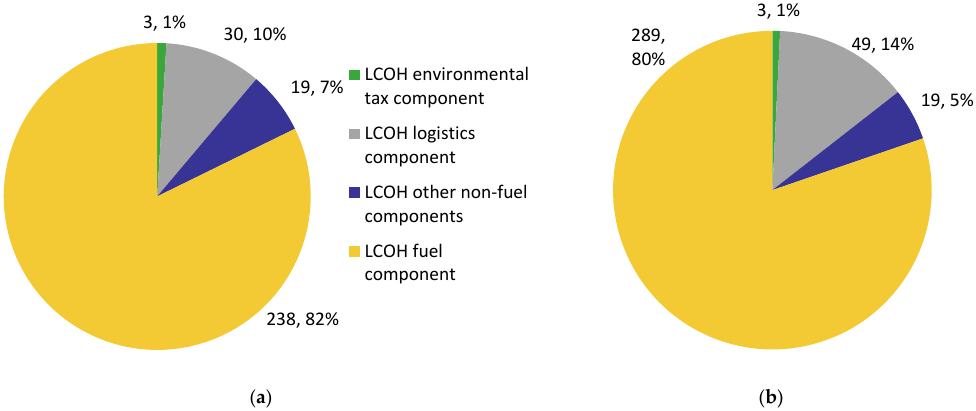
Figure 6. LCOH structure from KZOT BRS 1000 Comfort BM (1 MW) from straw pellets: ( a ) January 2022; ( b ) July 2022.